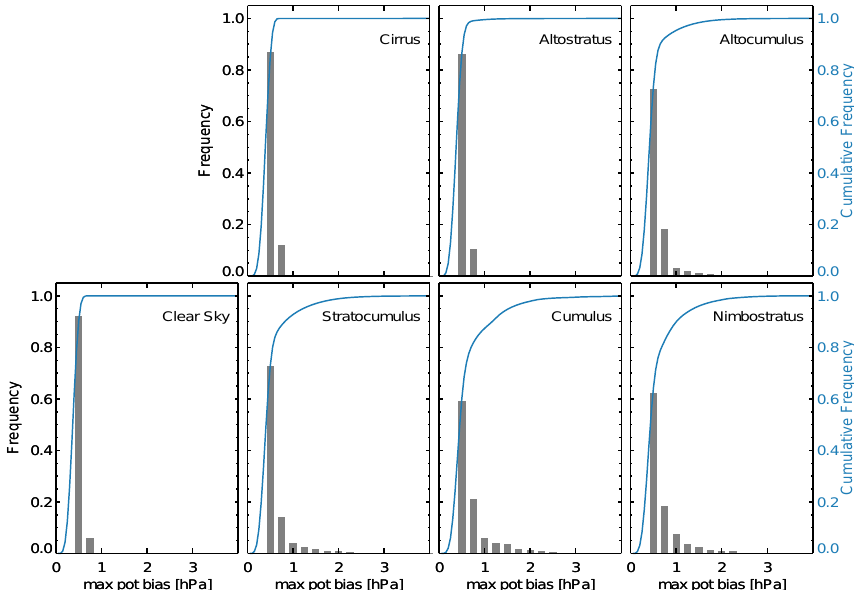
Figure 9. Histogram (gray) and cumulative histogram (blue) of the maximum potential biases for CloudSat-driven end-to-end retrievals for each of the CloudSat measurements available in 15 January 2007 (clear-sky and cloudy cases only).